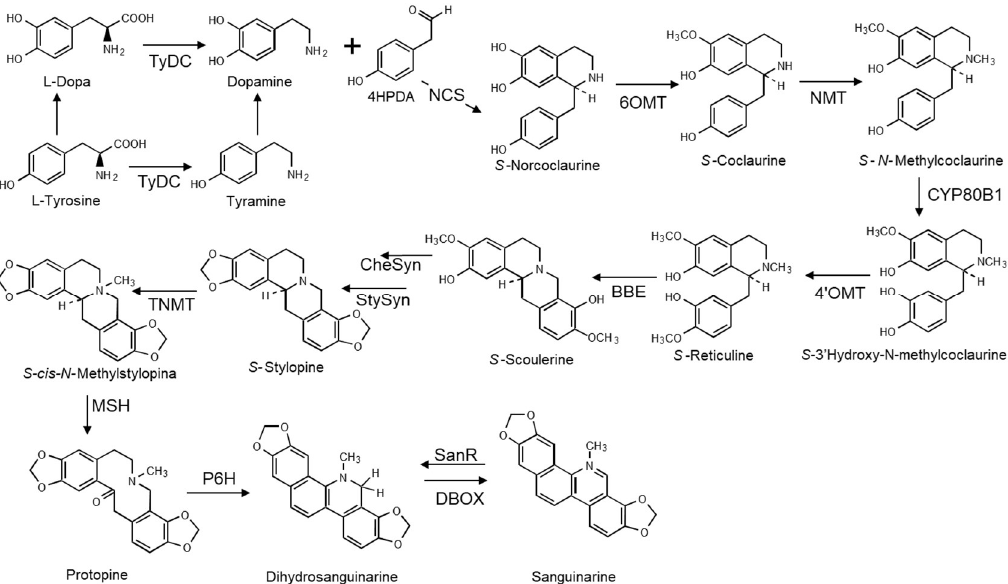
Figure 3. Biosynthetic pathways leading to sanguinarine. TyDC, l-tyrosine decarboxylase; NCS, s- norcoclaurine synthase; 6OMT, s-norcoclaurine-6- O -methyltransferase; BBE, reticuline oxidase: ber- berine bridge enzyme; CheSyn, cheilanthifoline synthase; StySyn, stylopine synthase; TNMT, s-tet- rahydroprotoberberine N-methyltransferase; MSH, methyltetrahydroprotoberberine 14-monooxy- genase; P6H, protopine 6-hydroxylase; DBOX, dihydrobenzophenanthridine oxidase; and SanR, sanguinarine